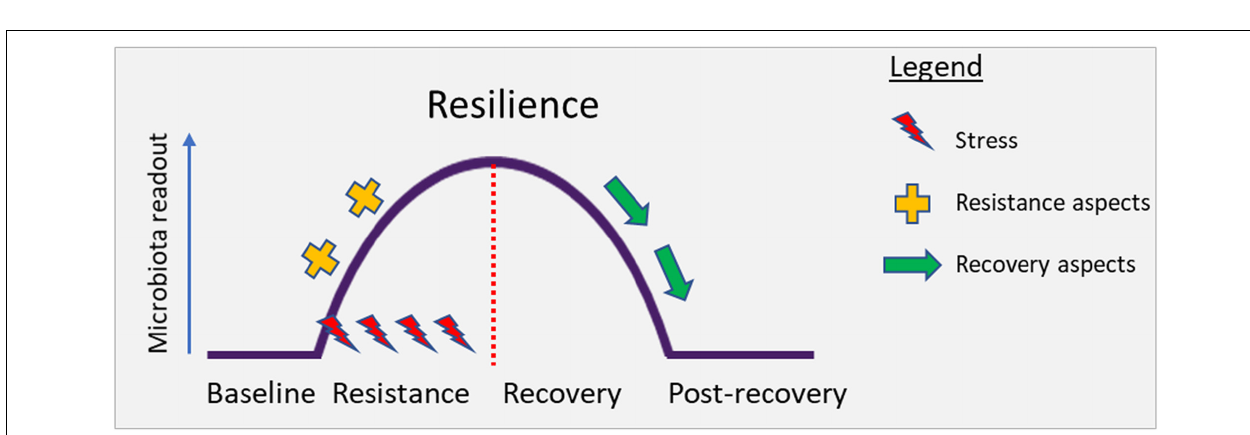
FIGURE 1 | Conceptual illustration depicting the native state of an ecosystem, its perturbation, the possibility of returning to its original state or transitioning to a new state (alternative stable state) (inspired by Folke et al., 2004).